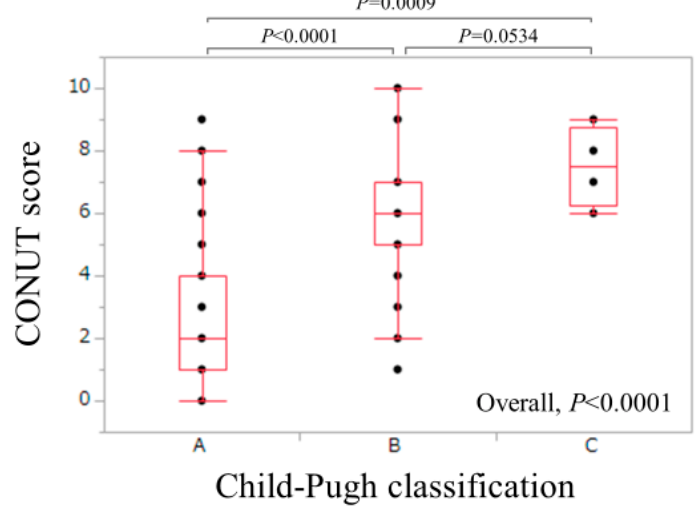
Figure 1. The CONUT score according to Child-Pugh classification. The CONUT score ranged from 0 to 9 (median, 2) in Child-Pugh A ( n = 198), 0 to 10 (median, 6) in Child-Pugh B ( n = 62) and 6 to 9 (median, 7.5) in Child-Pugh C ( n = 4) ( p values: Child-Pugh A vs. B, p < 0.0001; Child-Pugh B vs. C, p = 0.0534, Child-Pugh A vs. C, p = 0.0009; overall, p < 0.00001).